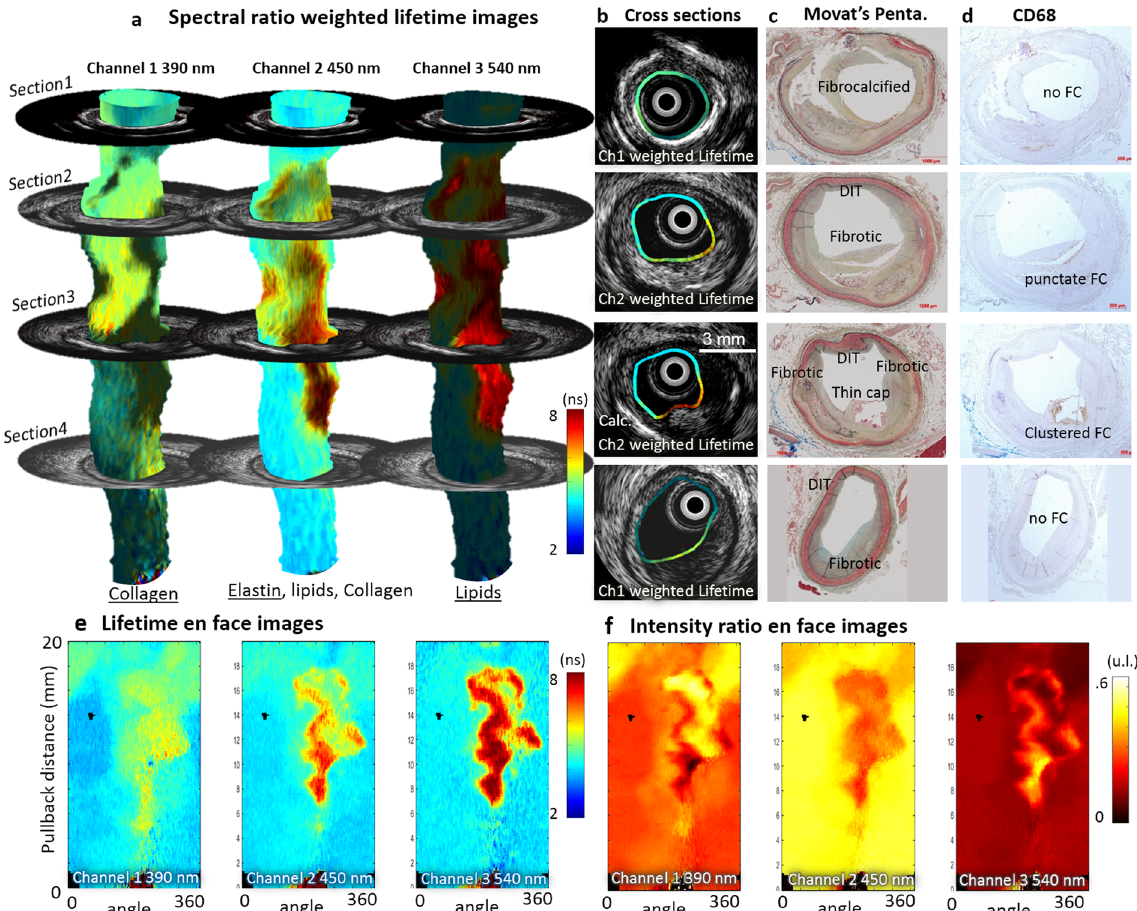
Figure 4. FLIm biochemical information supplements IVUS for the assessment of atherosclerotic lesion pathophysiology. Spectral ratio weighted lifetime images map the measured lifetime (color), as well as relative strength of the signal (brightness) for channels 1 (Collagen), 2 (Elastin, some collagen and lipids) and 3 (lipids, ceroid and lipofuscine) of the instrument. Section 1 presents a fibrocalcified lesion. Areas of superficial calcification (3 to 9 o’clock) present less fluorescence from collagen (channel 1) than the rest of the vessel. Section 2 presents diffuse intimal thickening (DIT, upper quadrant) as well as a fibrotic lesion with a deeper necrotic core (lower quadrant), easily identifiable in the IVUS cross section. The increased presence of collagen in the fibrotic area corresponds to high fluorescence intensity in channel 1. Infiltration of punctate foam cells (FC) in the lower right quadrant (see CD68) corresponds to increased lifetime in channel 2 and some low level fluorescence in channel 3. Section 3 presents a thin cap fibroatheroma (TCFA) in the lower right quadrant. The fluorescence signature of this area is characterized by an absence of channel 1 signal (no collagen) and long lifetime in channels 2 and 3 with a maximum emission in channel 3 (large amounts of lipids/ceroid/ lipofuscine). Other locations in the section present a signature expected from DIT/fibrotic lesions (collagen/ elastin). Calcification from 6–9 o’clock is readily detected by IVUS. Section 4 presents DIT (top, left) and a fibrotic lesion (bottom, right). The fibrotic area can be differentiated from DIT by its higher collagen content (increased channel 1 intensity, longer channel 2 lifetime). The absence of infiltrated FC (see CD68) in this fibrotic area is consistent with the much lower lifetime observed here with respect to the fibrotic region in section 1. Proteoglycans, identified by the alcian blue color in the 6 to 8 o’clock region of the Movat’s section may explain the increase in lifetime observed at this location in the channel 1 image. En face images of lifetime ( e ) and intensity ratio ( f ) used to compute ratio weighted lifetime images shown in ( a